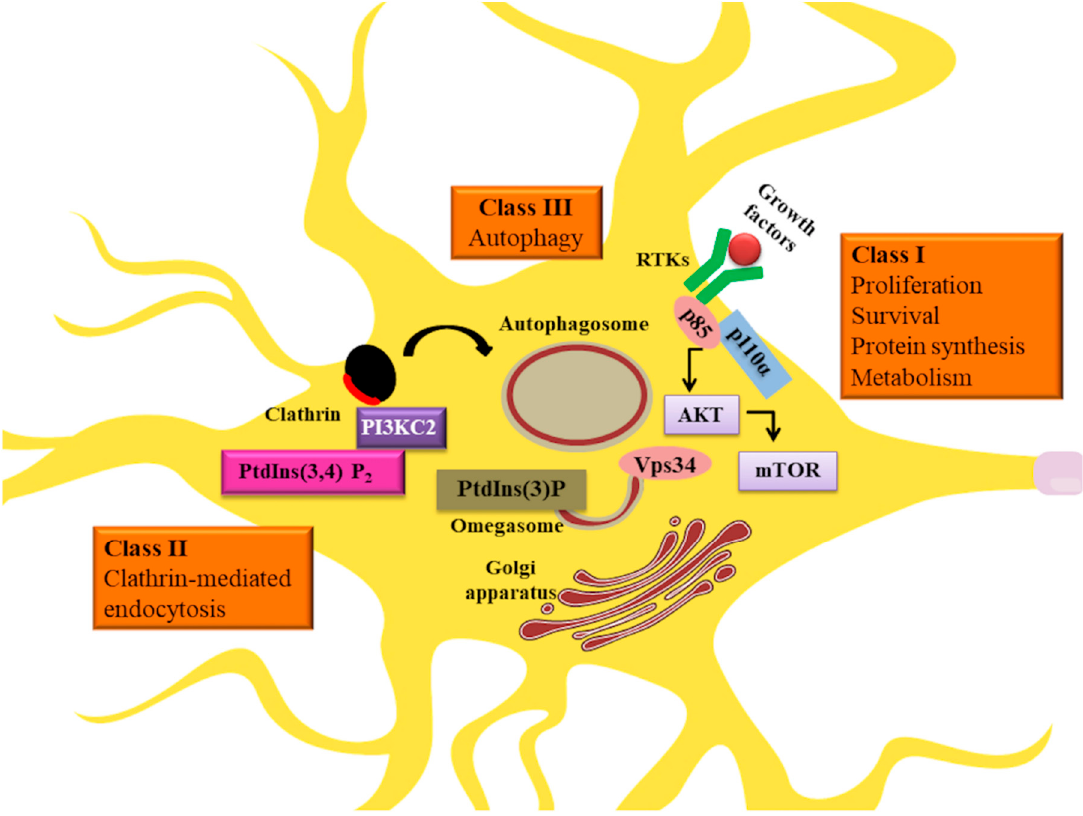
Figure 1. Involvement of different phosphoinositide 3-kinase (PI3K) classes in neuronal function. Class I acting through receptor tyrosine kinase (RTK) pathways mediate survival, proliferation, protein synthesis, and metabolism. Class II participates in vesicular trafficking and class III in autophagy.